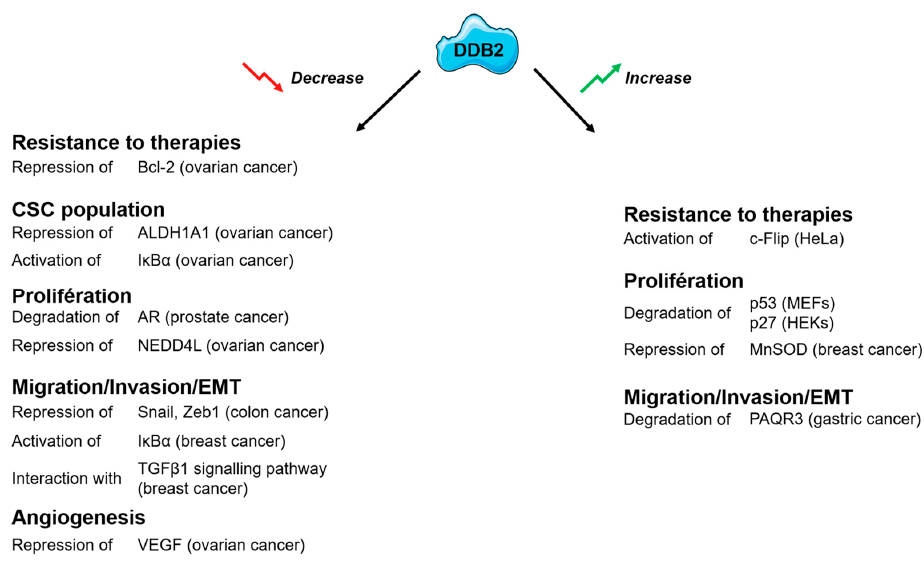
Figure 2. Roles of the DDB2 (Damage-specific DNA-binding protein 2) protein and its identified partners. AR (Androgen Receptor), ALDH1A1 (Aldehyde dehydrogenase 1 family, member A1), Bcl-2 (B-cell lymphoma 2), c-Flip (Cellular FLICE-like inhibitory protein, EMT (Epithelial–mesenchymal transition), HEKs (Human epidermal keratinocytes), I κ B α (nuclear factor of kappa light polypeptide gene enhancer in B-cells inhibitor, alpha), MEFs (Mouse embryonic fibroblasts), MnSOD (Manganese superoxide dismutase), NEDD4L (Neural precursor cell expressed developmentally downregulated gene 4-like), PAQR3 (Progestin and adipoQ receptor family member 3), TGF- β 1 (Transforming growth factor beta 1), VEGF (vascular endothelial growth factor), Zeb1 (Zinc finger E-box-binding homeobox 1).